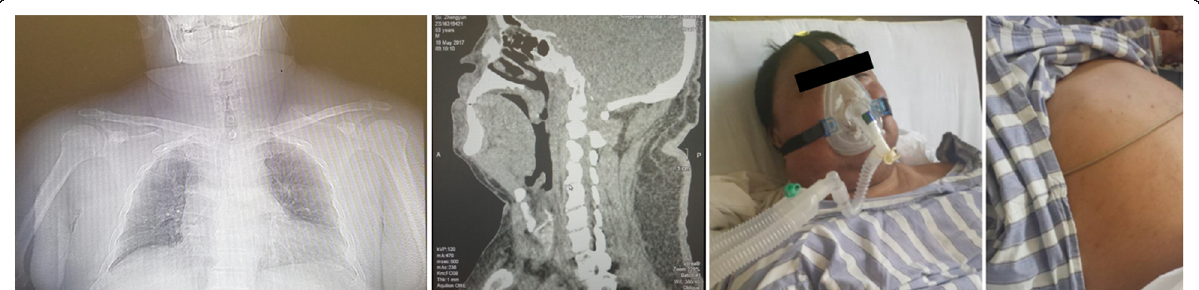
Fig. 3 Abdominal distension limited the use of Drager